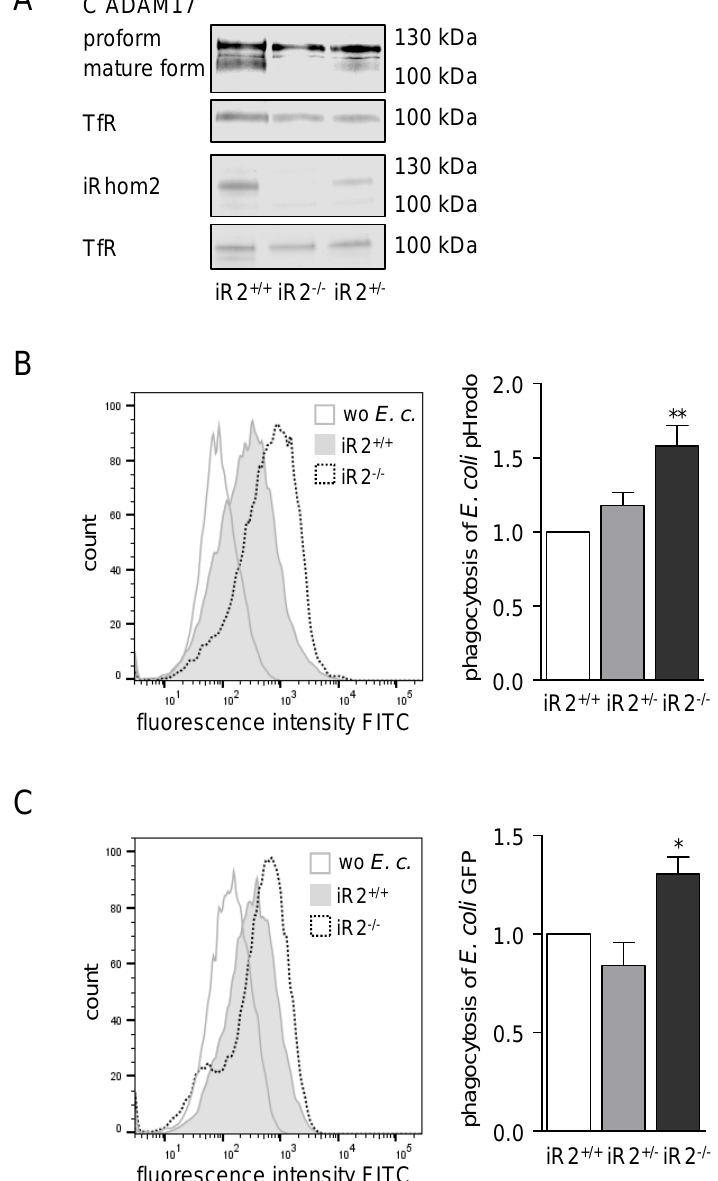
Figure 3. Deficiency or inactivation of iRhom2 in BMDMs enhances phagocytosis of E. coli , ( A ) BMDMs from heterozygous (iR2 +/ − ) or homozygous (iR2 − / − ) iRhom2 KO mice and their wild type littermates (iR2 +/+ ) were analysed for their iRhom2 and ADAM17 protein expression by Western blot. Transferrin receptor was detected as loading control. ( B , C ) BMDMs as described in A were exposed to E. coli pHrodo green ( B ) or living E. coli expressing GFP ( C ) and assayed for phagocytosis by flow cytometry. Results are shown as representative histograms and as geometric mean fluorescence of the cells in relation to that of the littermate control. Data are shown as mean and SD of three independent experiments. Significant differences compared to the respective control are indicated as asterisks (* p < 0.05, ** p < 0.01, *** p < 0.001).